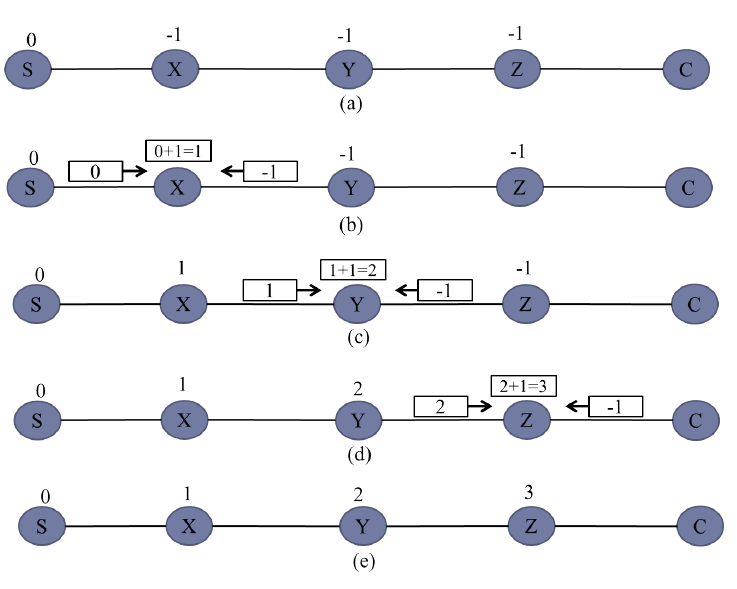
Figure 4. Dynamic ID assignment